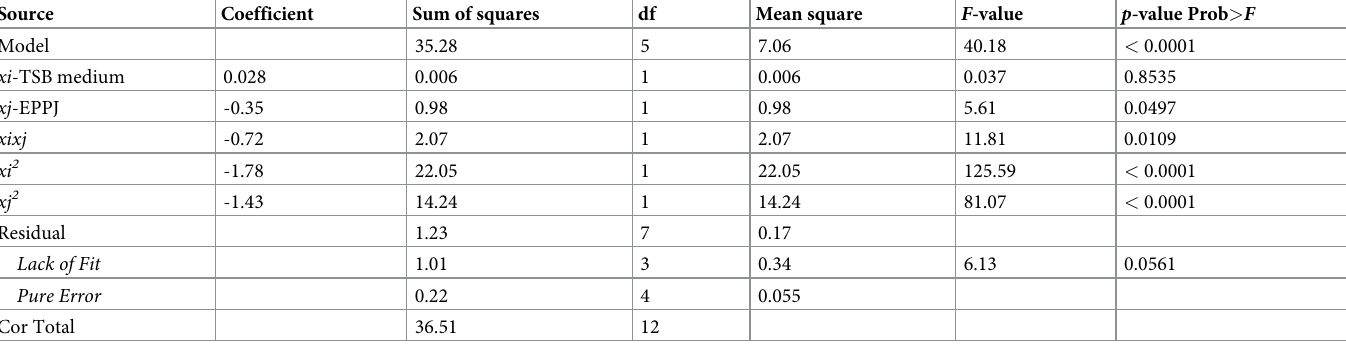
Table 3. ANOVA analysis of TSB medium and extracted pineapple peel juice (EPPJ) effects on PHAs production after fitting with response surface quadratic model. Source